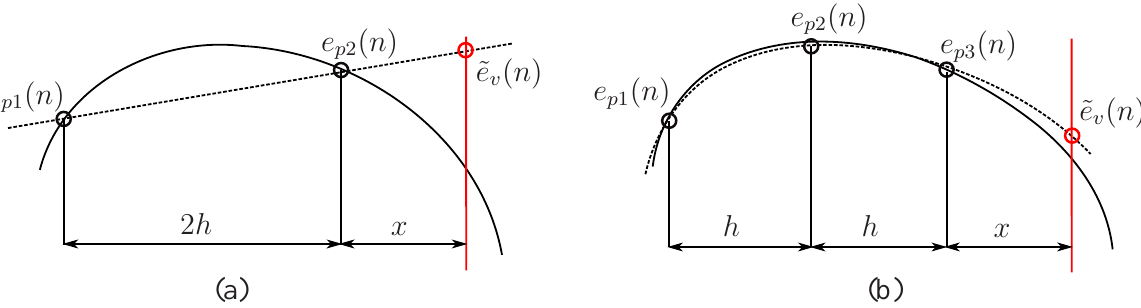
Figure 5 . Diagram of (a) two microphone linear forward difference extrapolation; and (b) three micro- phone quadratic forward difference extrapolation. The black curved line represents the actual pressure field and the dashed line represents the pressure